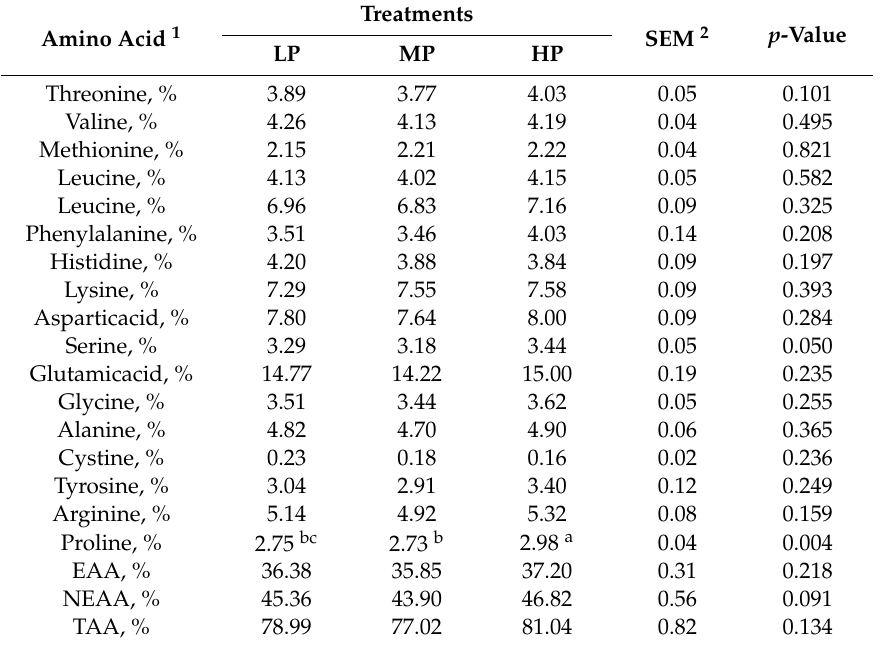
Table 6. E ff ects of three di ff erent dietary protein levels on the amino acid profile of longissimus dorsi muscle in Tibetan sheep (n = 4 per